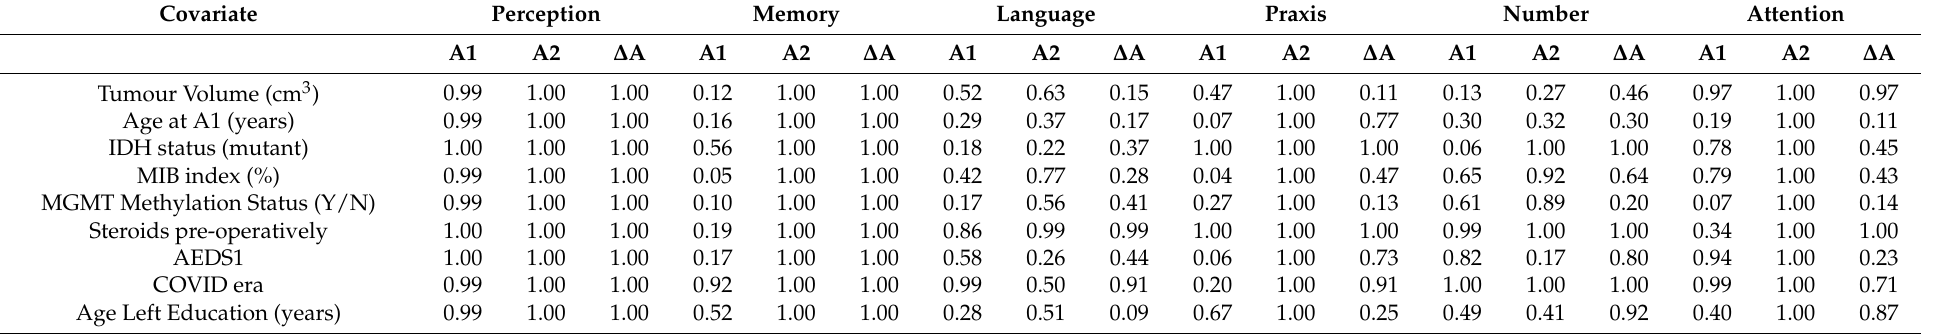
Table 2. Multivariate regression model of the association between each characteristic and cognitive deficit at A1, A2, and ∆ A. Covariate Perception Memory Language